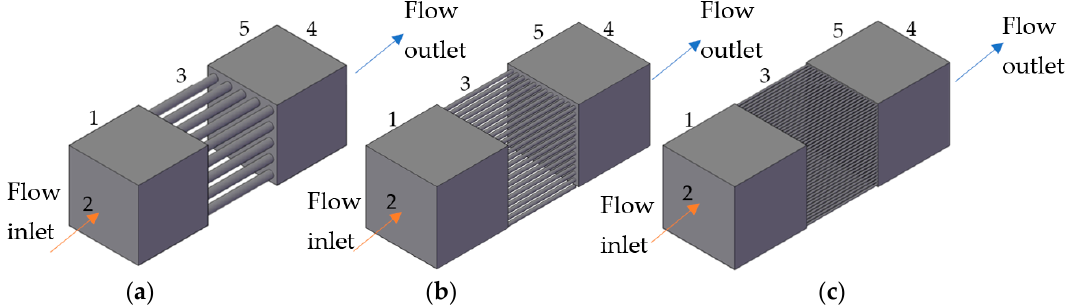
Figure 1. Three types of principal model structures with (1) inlet cube channel, (2) inlet surface, (3) cylindrical tube imitating mycelium porous media idealization, (4) outlet surface and (5) outlet cube channel. ( a ) Structure with 25 cylinders; ( b ) Structure with 144 cylinders; ( c ) Structure with 625